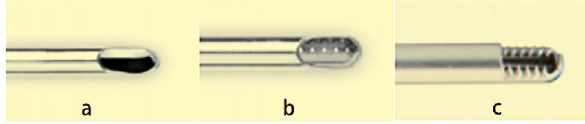
Figure 1. Types of arthroscopy shavers 9 .